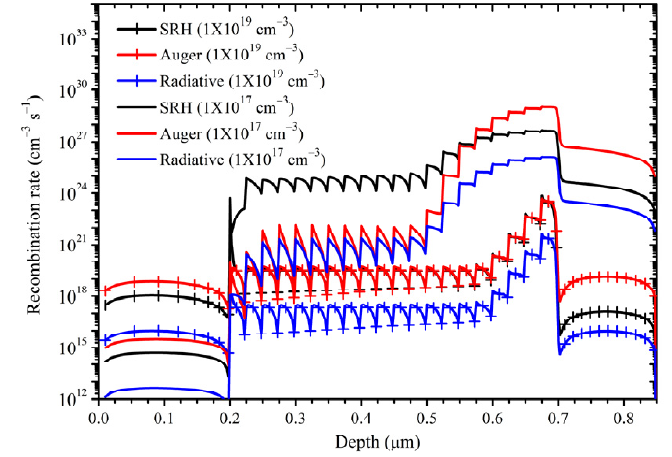
Figure 7. Radiative, Auger and Shockley–Read–Hall recombination rates under 1-sun at AM1.5 standard light conditions.